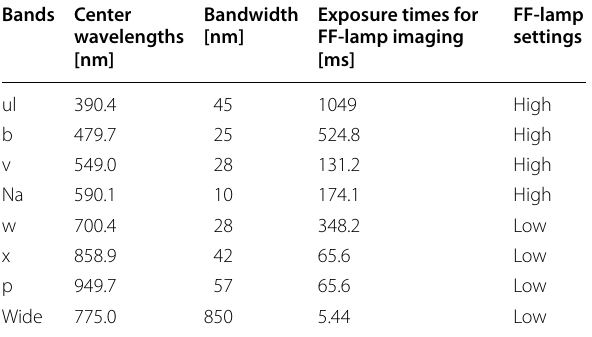
Table 1 Settings for performing health-check imaging with the FF lamp